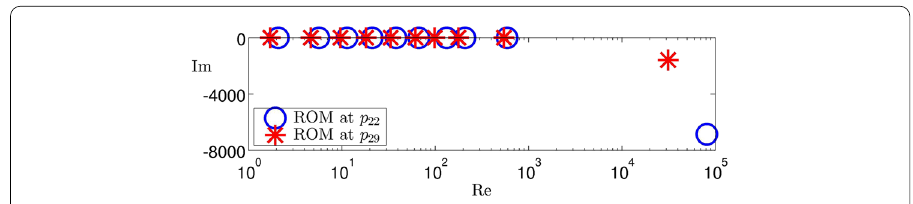
Fig. 8 The poles of the ROMs for p 22 and p 29 , respectively